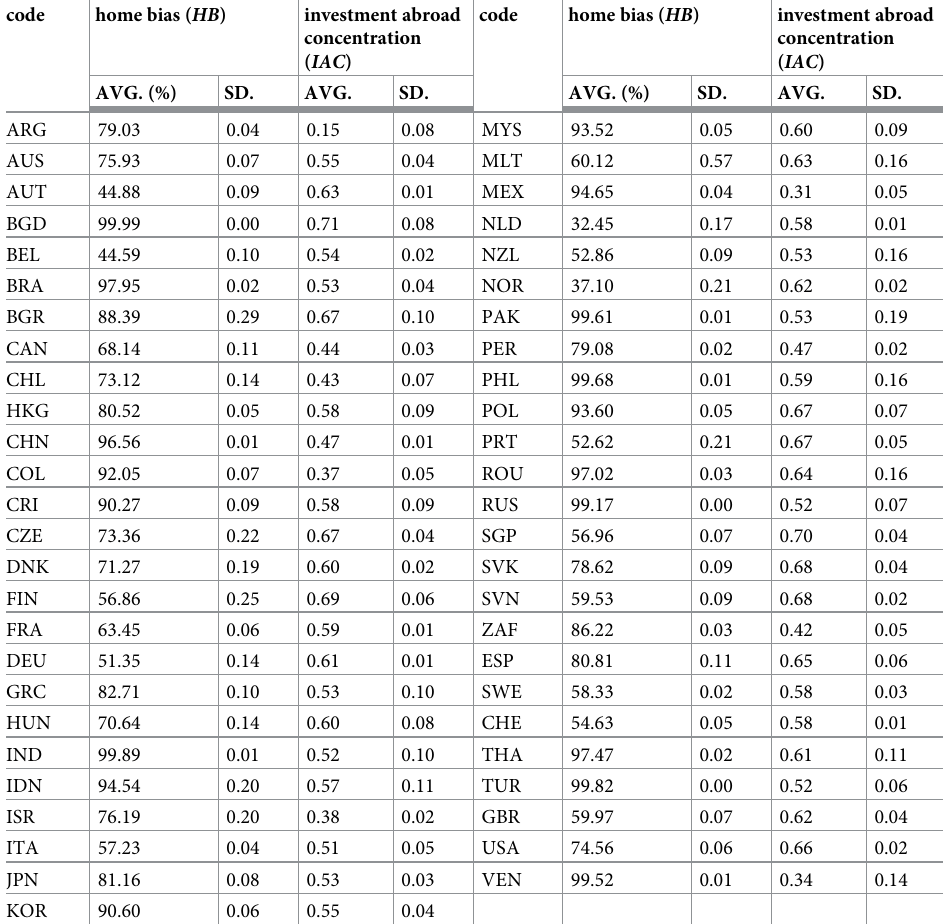
Table 1. Mean and standard deviation of HB and IAC by